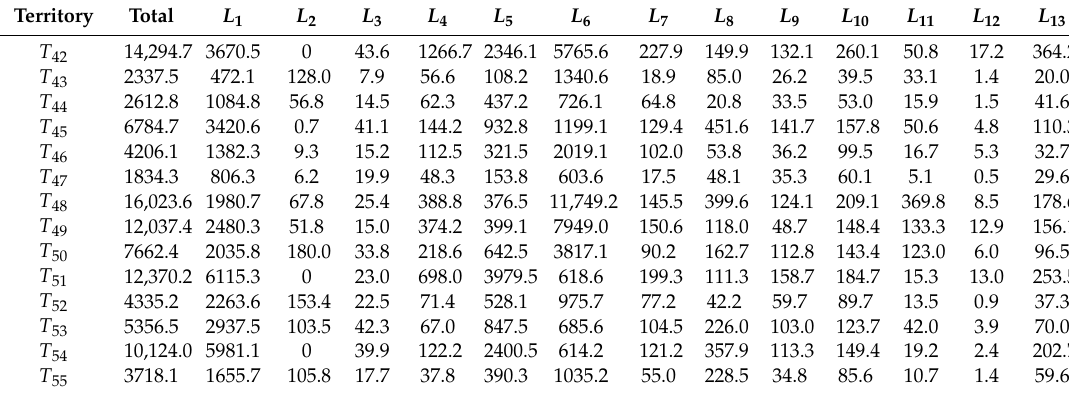
Table A5. Land acreage data of the Volga Federal District in thousand hectares. Mean values for 2010–2018.